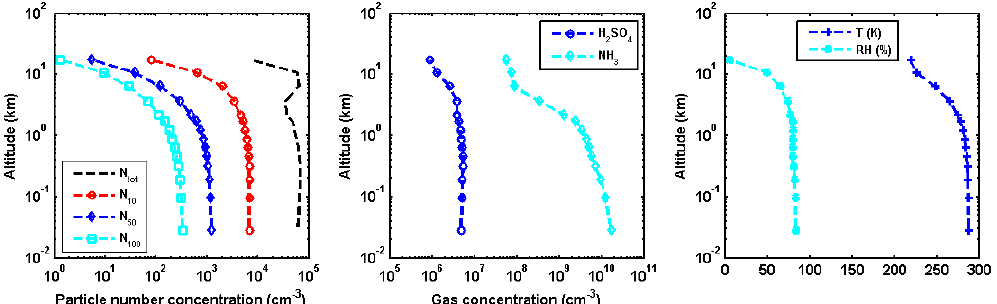
Figure 3. Vertical profiles of simulated variables averaged (arithmetic mean) over May 2008 and the whole simulation domain. Left panel: number concentration (cm − 3 ) of particles larger than 0.8nm ( N tot ), 10nm ( N 10 ), 50nm ( N 50 ), and 100nm ( N 100 ). Middle panel: gas- phase concentration (cm − 3 ) of sulfuric acid (H 2 SO 4 ) and ammonia (NH 3 ). Right panel: temperature (K) and relative humidity (%). The PMCAMx-UF baseline simulation ACDC-TUV-DE is used (see Table